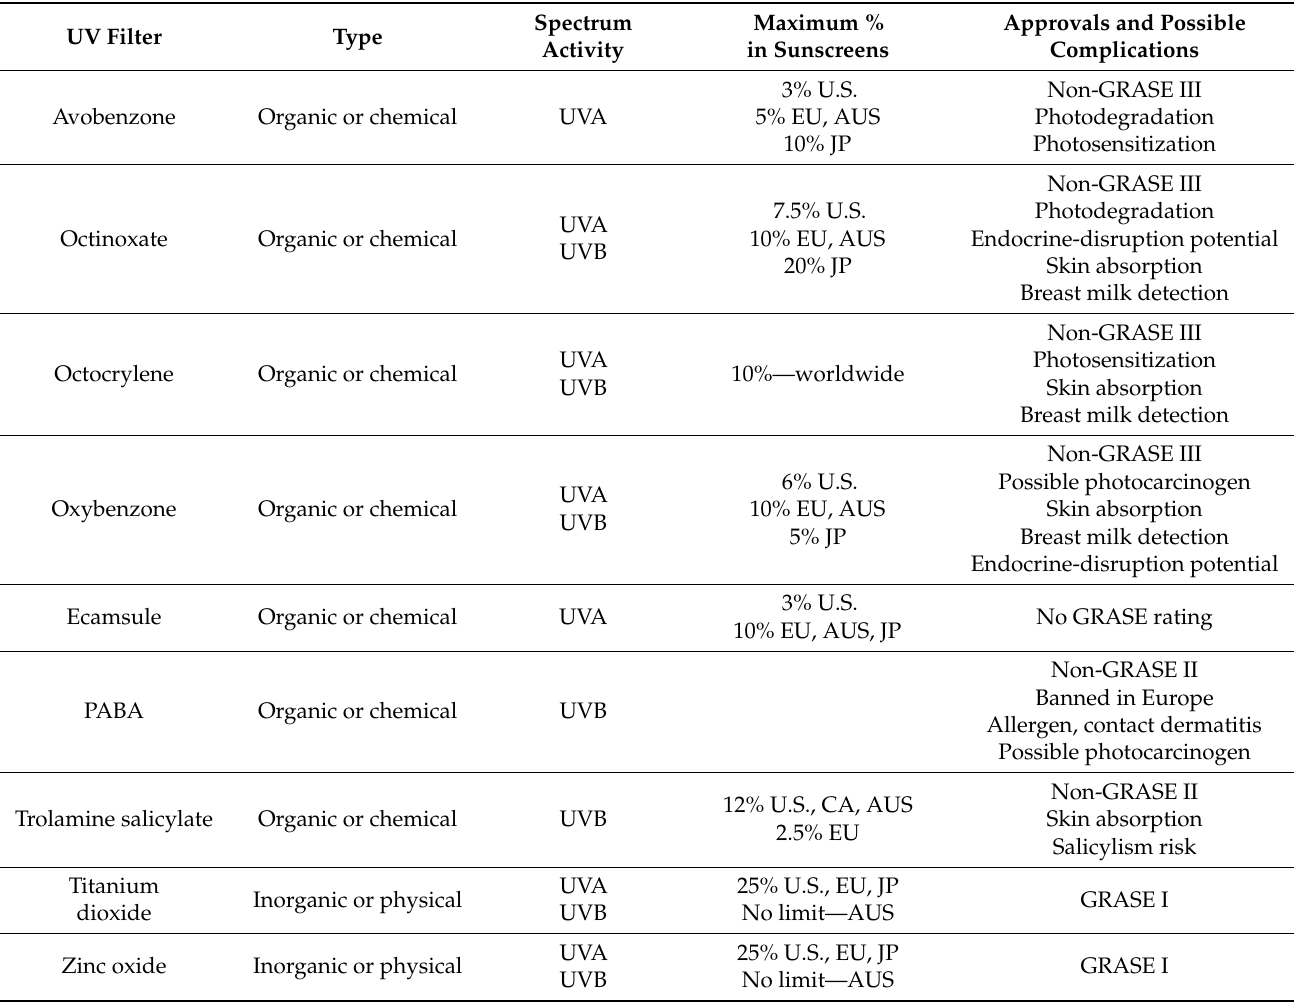
Table 1. Conventional synthetic UV filters approved worldwide: type, UV range of activity, maximum amount authorized in sunscreens, FDA category, and risks